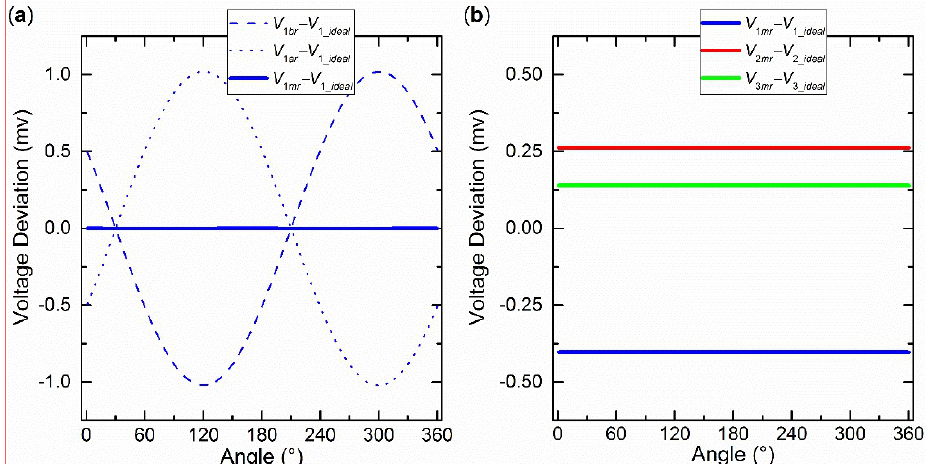
Figure 8. ( a ) The separate influence of O IS when L IS = 0.05 mm and α of O S on voltages when L S = 0.02 mm and α